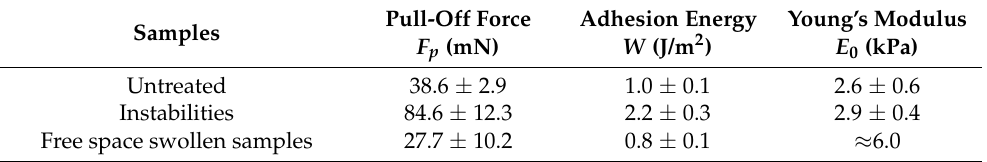
Table 1. JKR analysis of the adhesion tests. The pull-off force ( F p ), adhesion energy ( W ), and elastic modulus ( E 0 ) for each soft substrate obtained from the indentation measurements in Figure 4c. The uncertainties were calculated from the standard deviations by repeating the measurements at least three